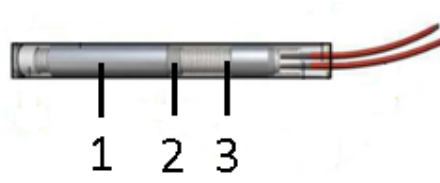
Fig. 1. Longitudinal section of experimental cylinder